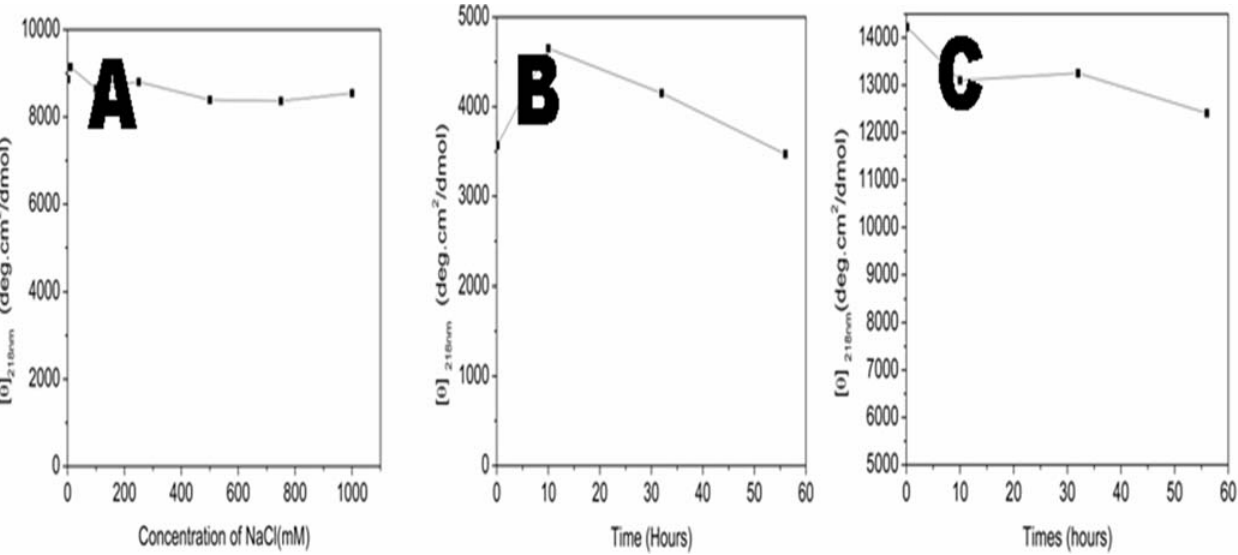
Figure 8. Influence of the ionic strength and denaturing agents. A) The effect of NaCl. The sample solution was incubated at various concentration of NaCl for , 2 hours. B) d-EAK16 was stable in 8 M urea, which is similar as previously report for l-EAK16. C) Effect of 0.1% SDS, likewise, it had little denaturing effect, similar as previously report of l-EAK16.